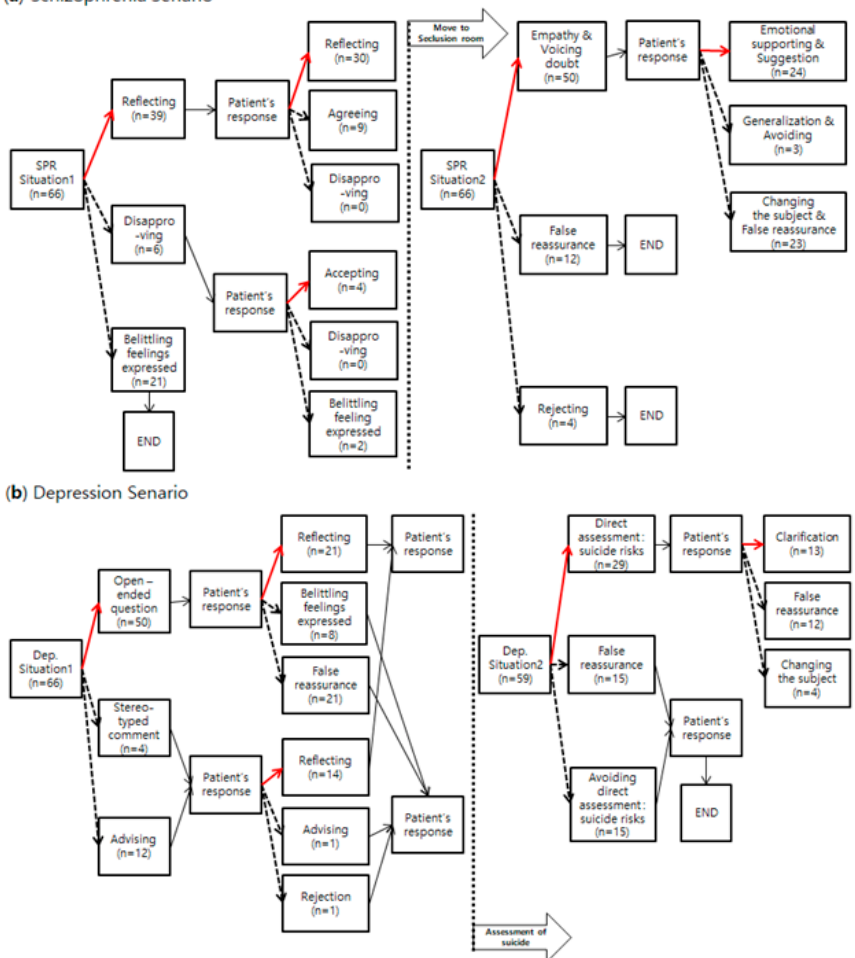
Figure 1. Red lines: the path for therapeutic communication skills; dotted lines: the path for non-therapeutic communication skills. n: number of students who chose the answer. ( a ) Schizophrenia scenario; ( b ) depression scenario.